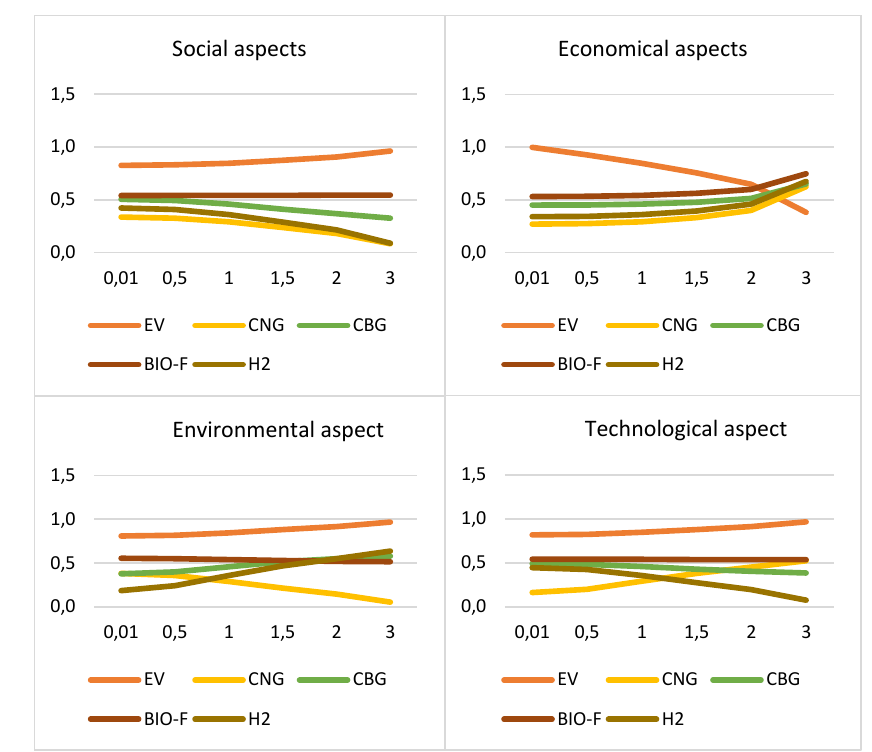
Figure 4. Sensitivity analysis for fuel